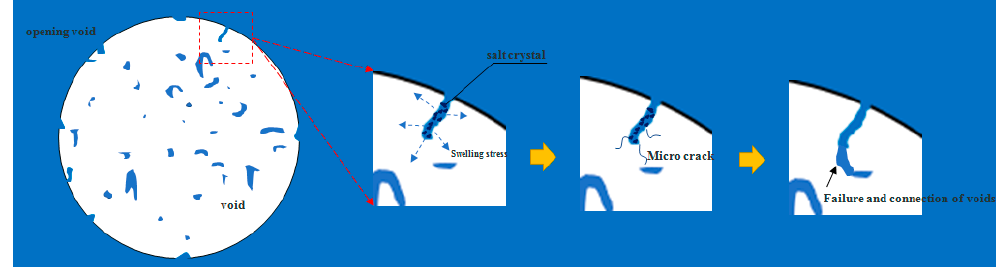
Figure 16. Volume change of single opening void.